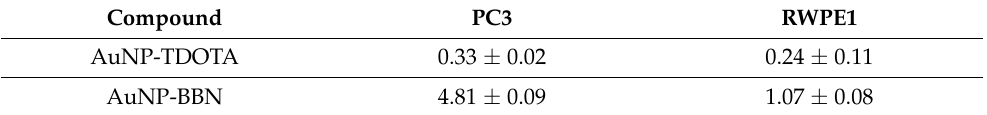
Table 1. Cellular uptake in whole PC3 and RWPE-1 cells by PIXE. Both cells were previously incubated with AuNP-TDOTA and AuNP-BBN at 36 µ g Au/mL for 4 h. The Au concentration in the whole cells is expressed in ng Au/10 6 cells. Values are shown as the mean ±